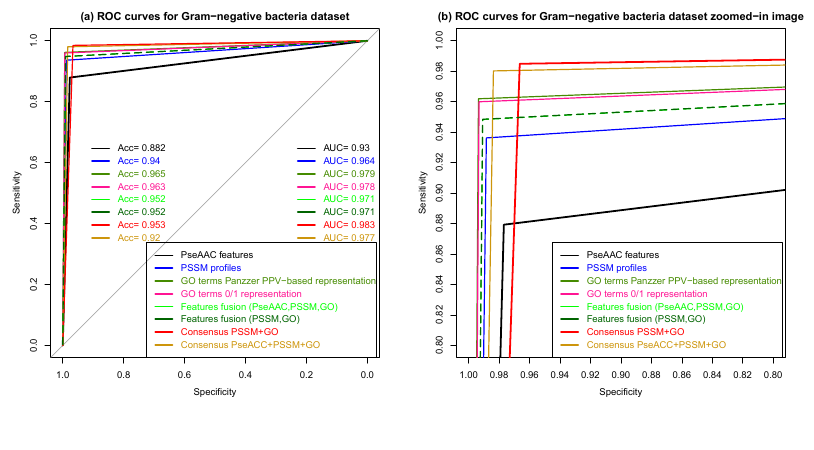
(b) ROC curves for Gram − negative bacteria dataset zoomed − in image Figure 6: ROC curves of cross-